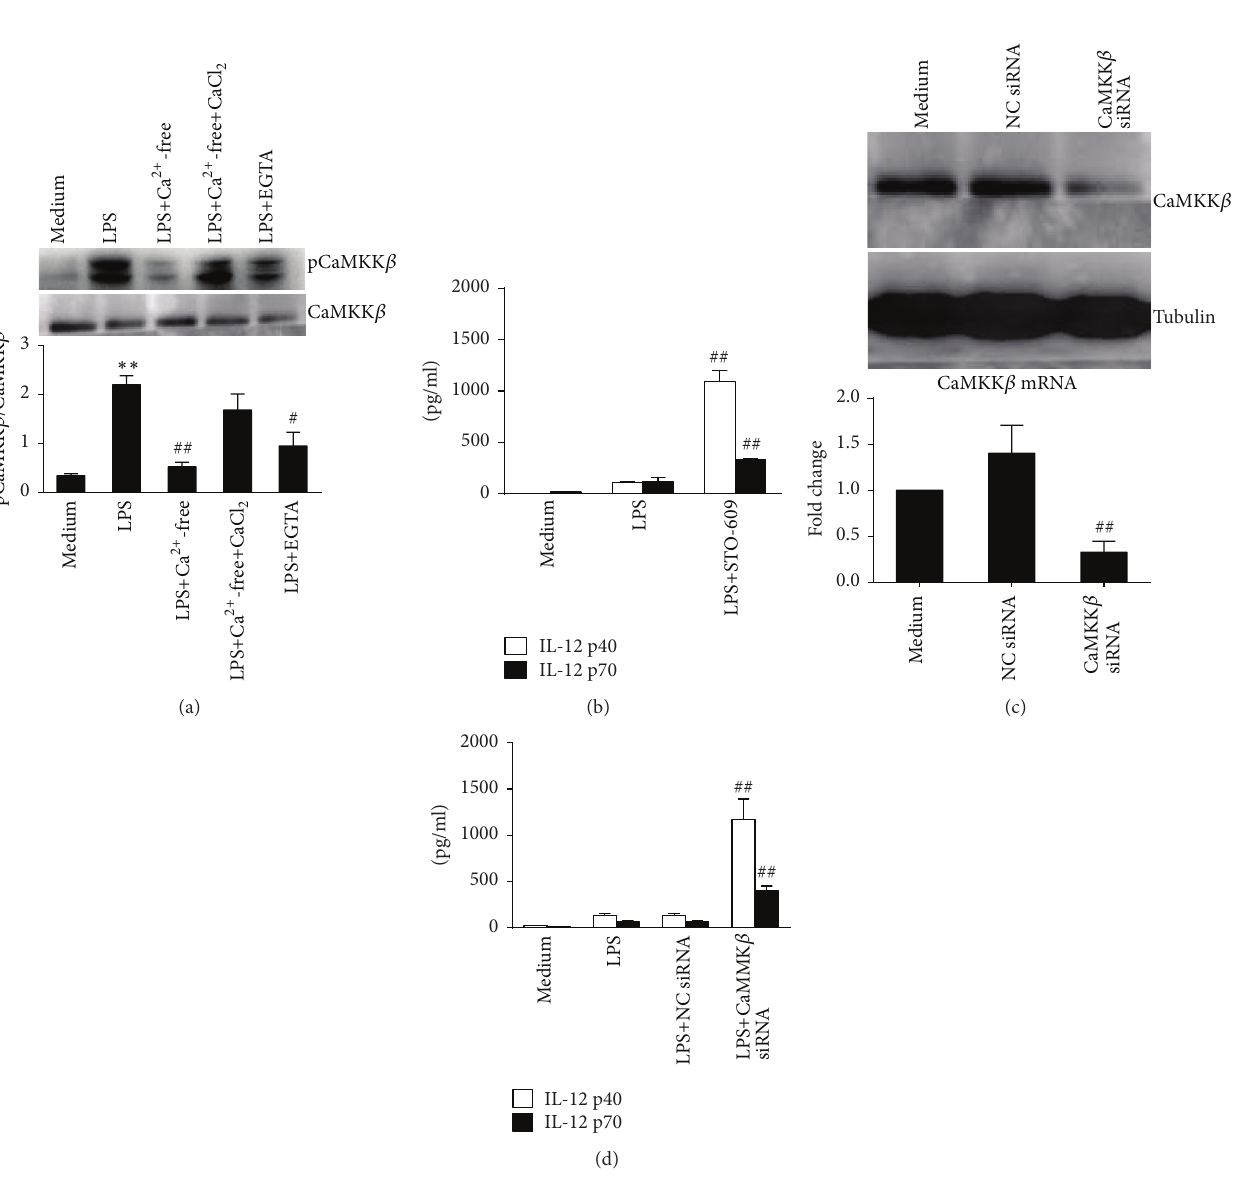
Figure 4: Activation of CaMKK 𝛽 mediates the inhibition of calcium-dependent IL-2 production in RAW 264.7 cells. (a) Cells were treated with LPS in normal DMEM, calcium-free DMEM, calcium-free DMEM with 2 mM CaCl 2 , or DMEM with 5mM EGTA for 30 min. Protein levels of CaMKK 𝛽 and pCaMKK 𝛽 were detected by western blot. Comparison was made for pCaMKK 𝛽 /CaMKK 𝛽 . ∗∗ 𝑃 < 0.01 versus medium; # 𝑃 < 0.05 and ## 𝑃 < 0.01 versus LPS ( 𝑛 = 3 ). (b) Cells were treated with LPS or LPS plus 1 𝜇 M STO-609 for 24 h. Supernatants IL-12 p40 and IL-12 p70 were detected. ## 𝑃 < 0.01 versus LPS for each cytokine ( 𝑛 = 3 ). (c) Cells were treated with negative control siRNA (NC siRNA) or CaMKK 𝛽 siRNA for 24h. mRNA and protein levels of CaMKK 𝛽 were detected by real-time PCR or western blot. ## 𝑃 < 0.01 versus NC siRNA ( 𝑛 = 3 ) for mRNA. (d) siRNA-treated cells were further stimulated by 100 ng/mL LPS for 24 h. Supernatants IL-12 p40 and IL-12 p70 were detected. ## 𝑃 < 0.01 versus LPS for each cytokine ( 𝑛 = 3